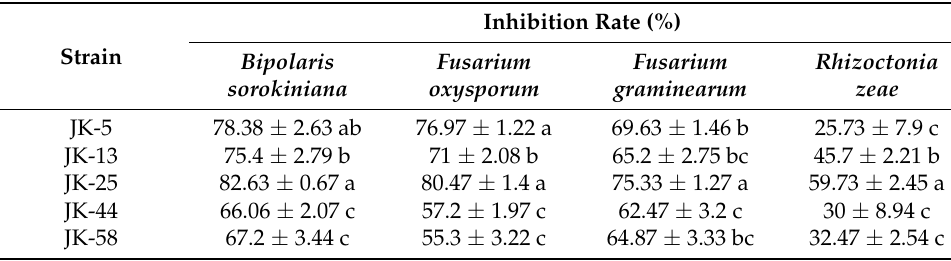
Table 1. Inhibition rate of pathogens by five strains of bacteria.